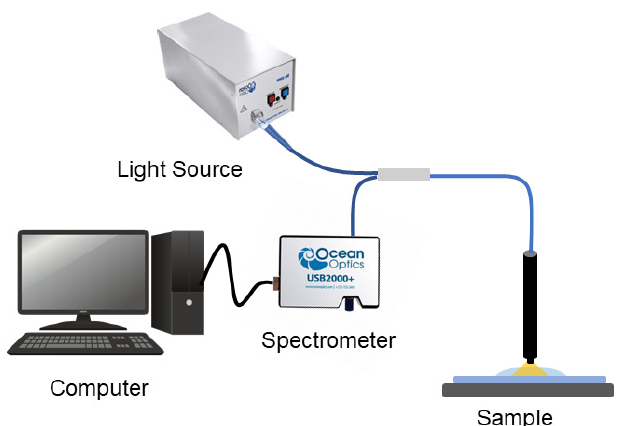
Figure 3. Experimental setup for the detection of chlorophyll using LSPR.